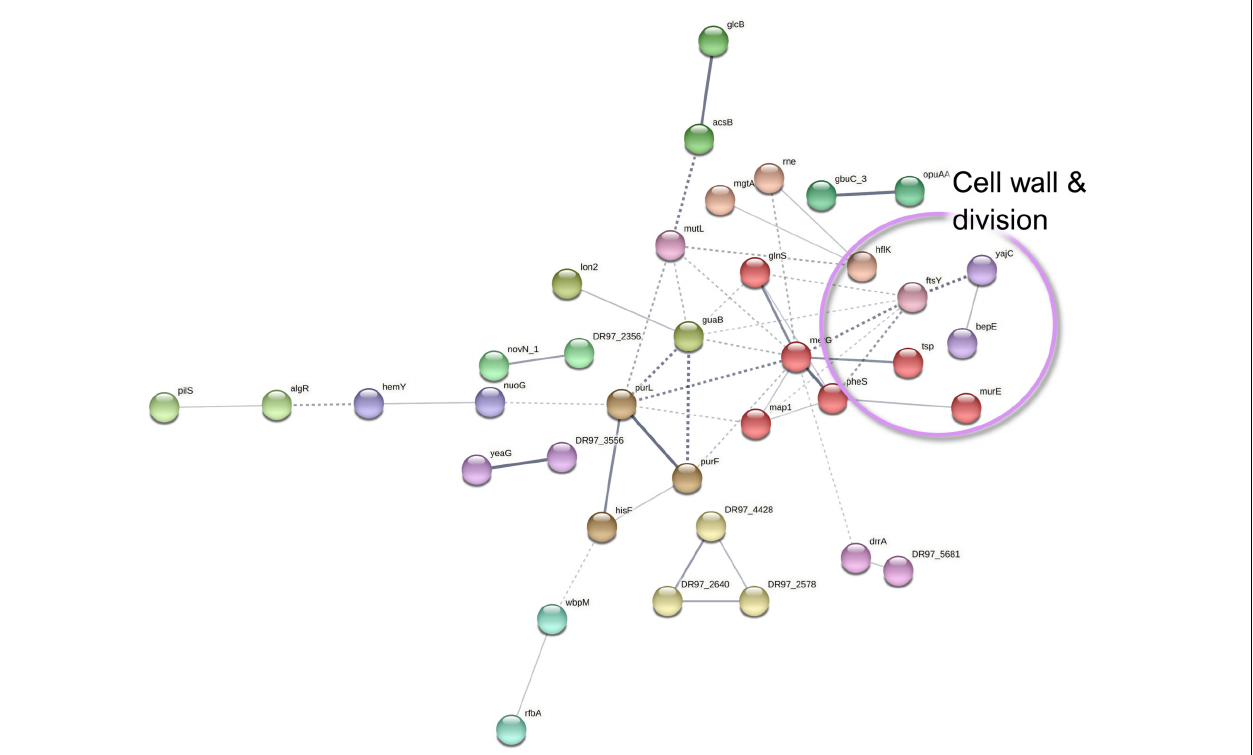
FIGURE 9 | A STRING database (Szklarczyk et al., 2019) network of interacting proteins with a significantly lower abundance in Pseudomonas aeruginosa co-culture versus monoculture surfaceome.